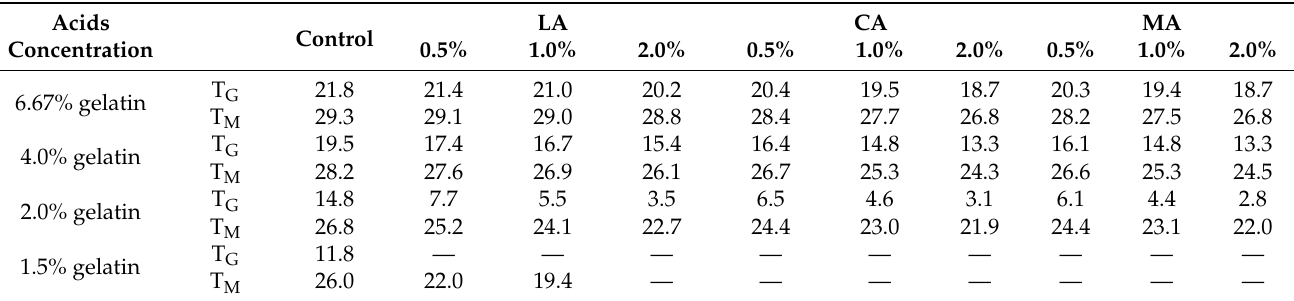
Table 2. The gelling (T G ) and melting (T M ) temperatures of tilapia skin gelatin dispersions (1.5–6.67% gelatin) as affected by the addition of lactic acid (LA), citric acid (CA), and malic acid (MA).